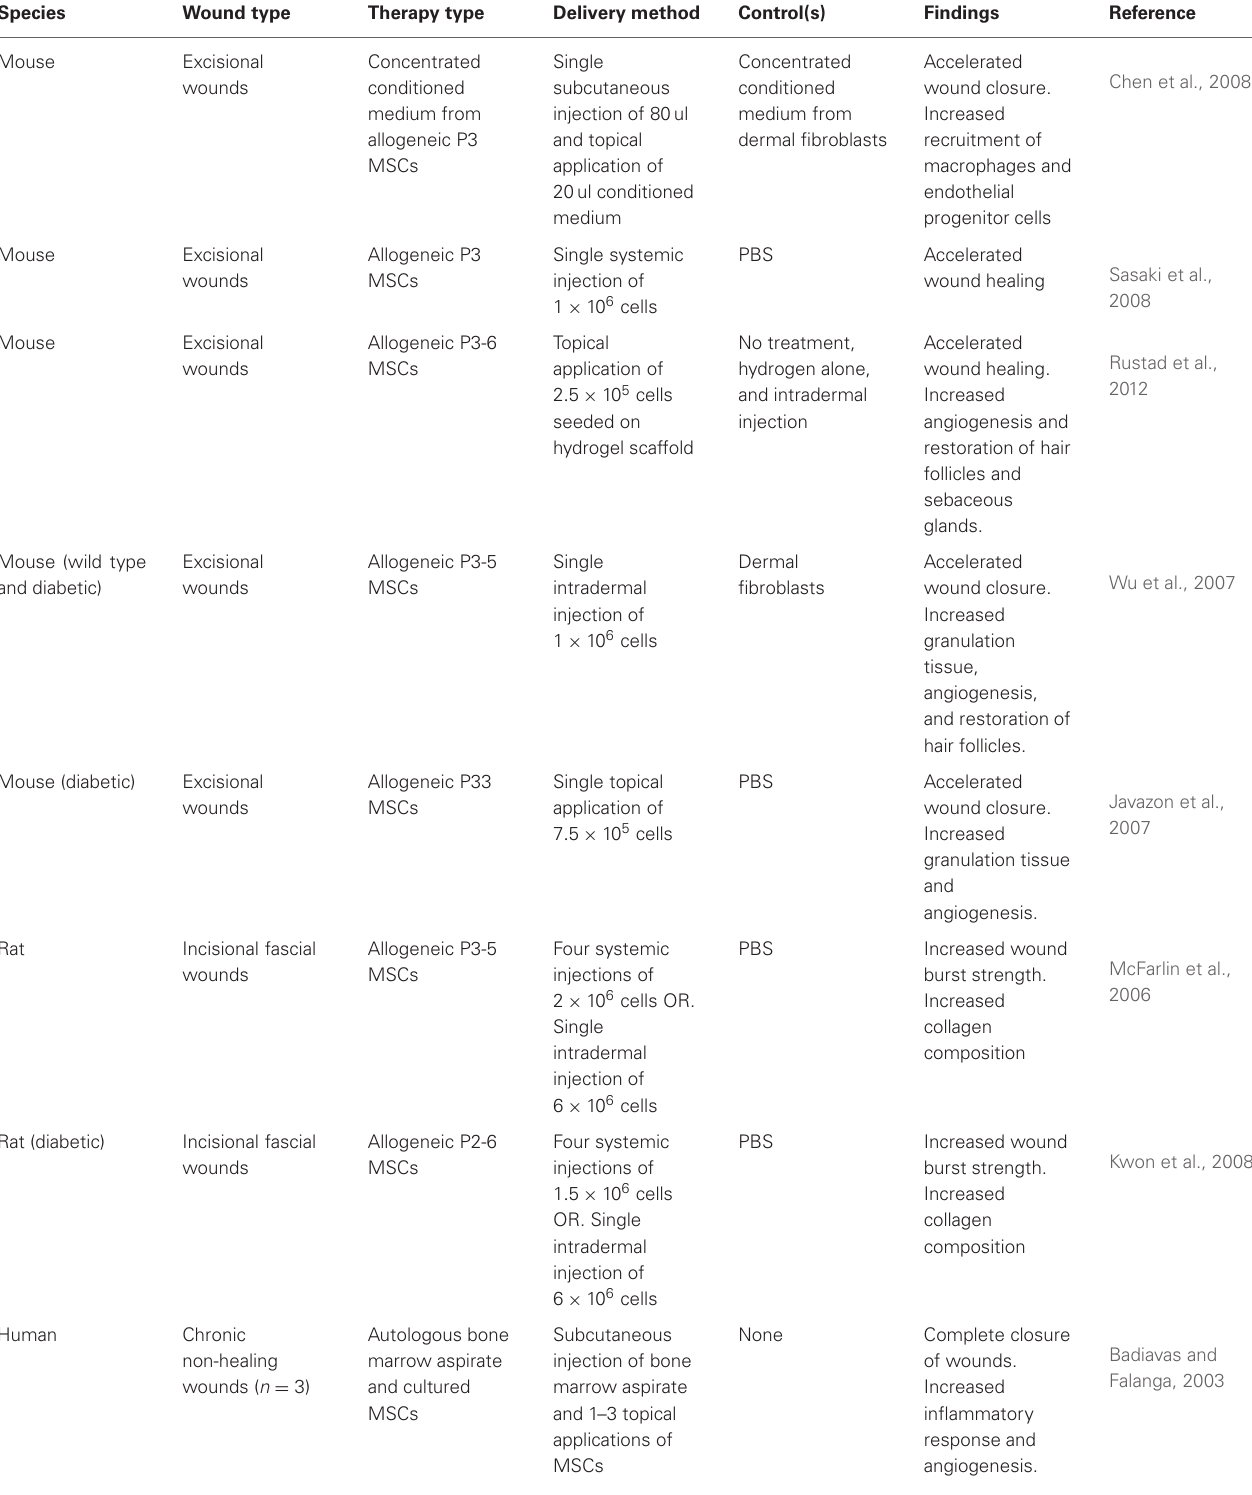
Table 1 | Study design and results for treatment of cutaneous wounds with mesenchymal stem cell therapy.